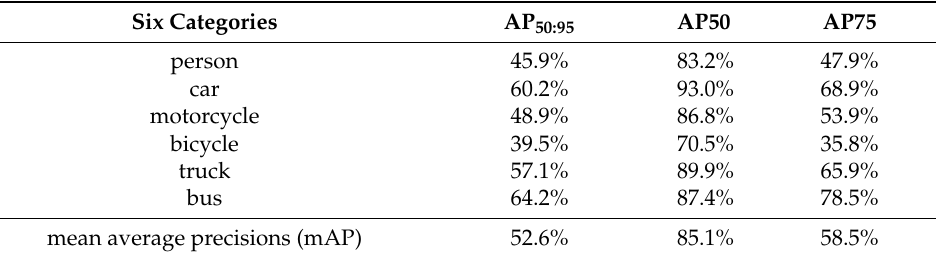
Table 7. The performance of